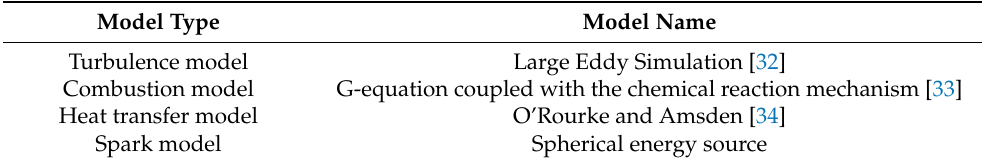
Table 1. Sub-models in the